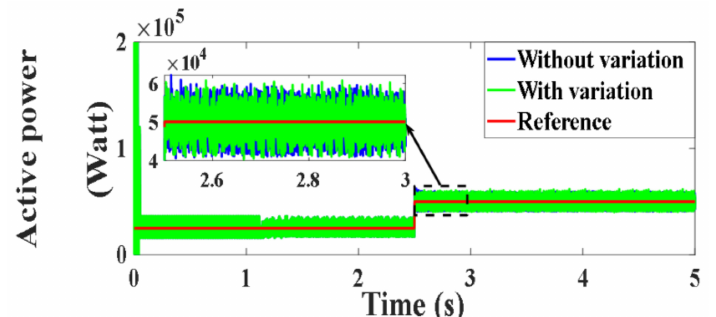
Figure 73. Active power under PVC (Watt).